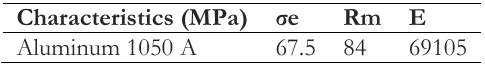
Table 1. Mechanical properties of 1050 A